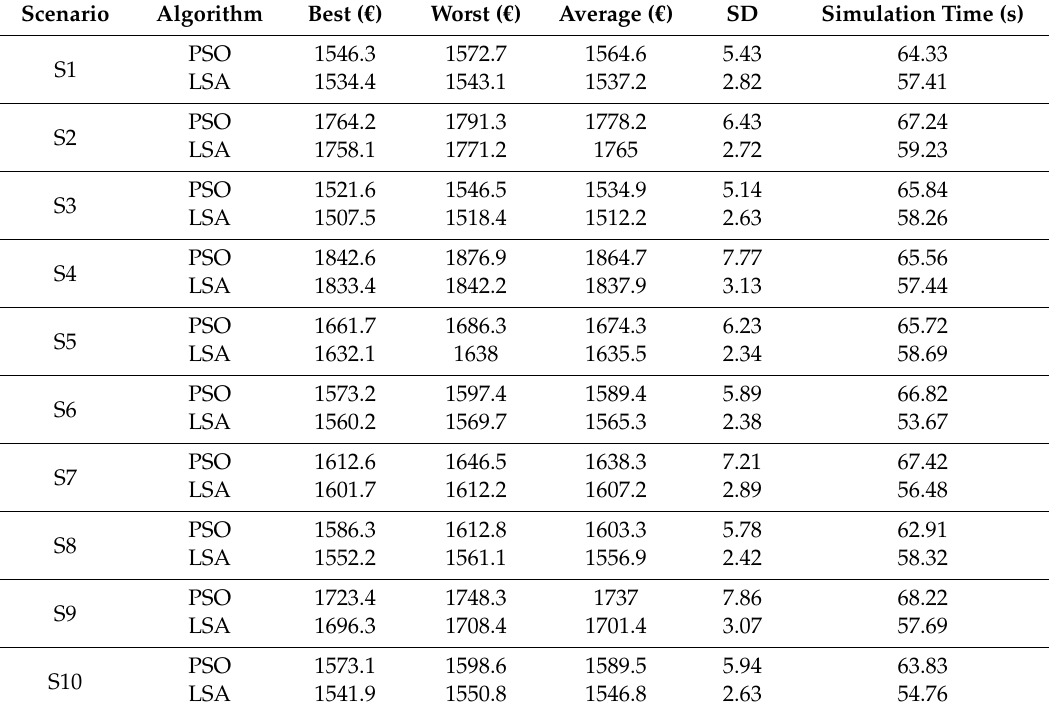
Table 3. Optimization results for 20 trials in part 2.